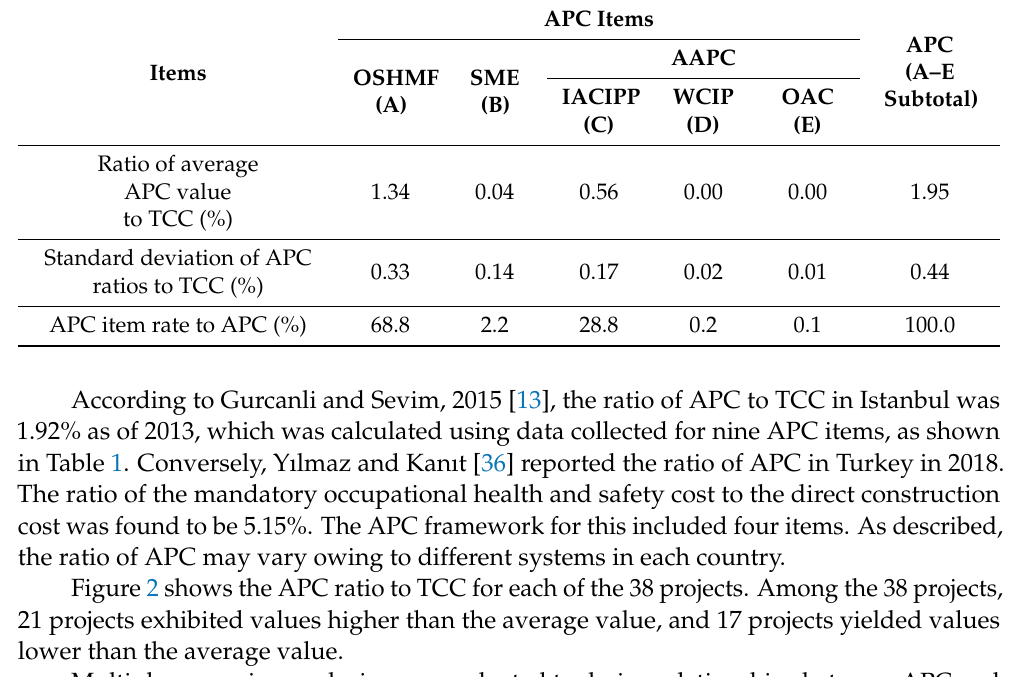
Table 7. Ratio analysis